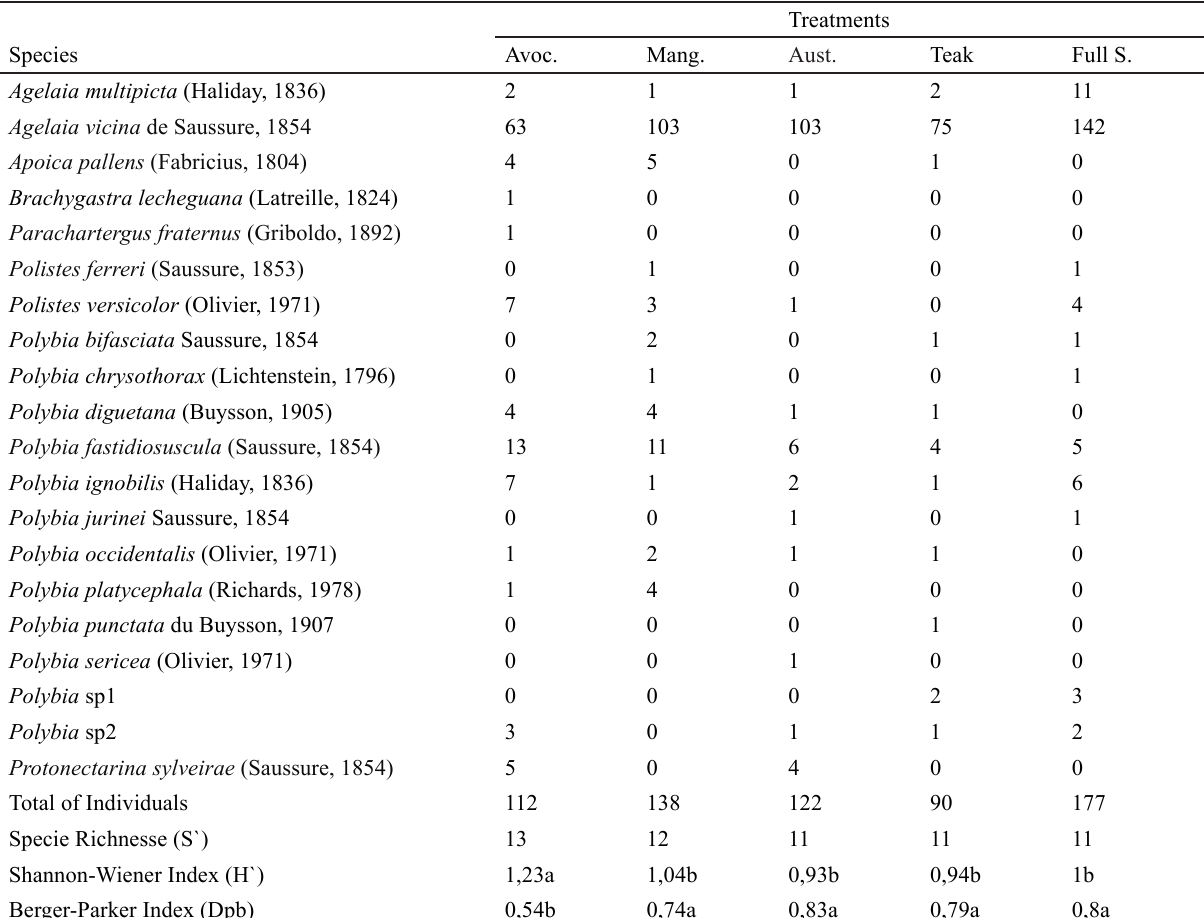
Table 2 . Richness, diversity and dominance of species of social wasps collected in Arabica coffee ( Coffea arabica L.) in different treatments. Avoc = Avocado; Mang = Mangium; Aust = Australian redcedar; Teak = Teak; Full S = Full